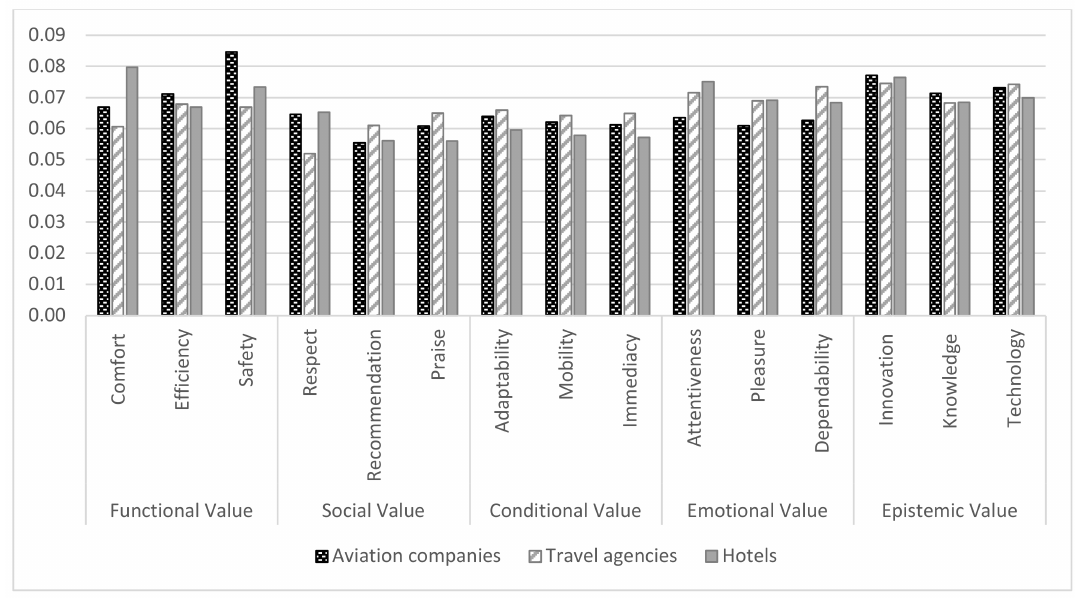
Figure 6. Relative weights comparison of the service quality attributes in the three